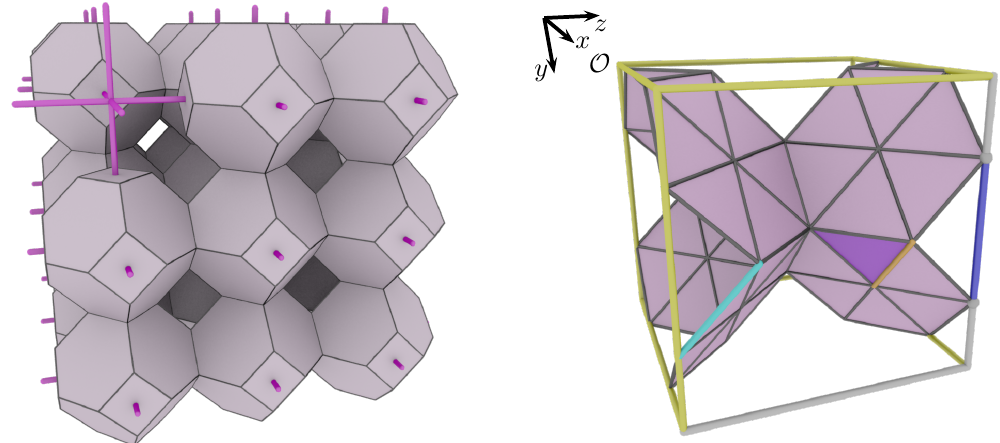
a Figure 4. Triangulated representation of the solid/void interfacial surface illustrated for a photonic crystal based on truncated octahedra. Both domains Ω and Ω are given by 1 2 truncated octahedra, that is 14-sided polytopes composed of eight regular hexagons and six squares [37]. The chosen unit cell Ω ( “ Ω in this case) is the cube with yellow edges. The L origin at the upper left corner of the cube is marked by O . The edges of the triangulation of S “ S are shown in black, and we have picked an arbitrary triangle o over which the L τ sum in Equation (13) goes with one of its three edges a marked in brown; see the sum in τη Equation (14). One of the four edges in E in Equation (13) is highlighted in turquoise. The j distances d in Equation (13) are illustrated as follows: the grey bar in the z -direction has jk length d “ 1 ; d “ d “ 0 . 5 along the other directions, for which half of the edge is in xy xz yz Region 0 (shown in blue for d xz